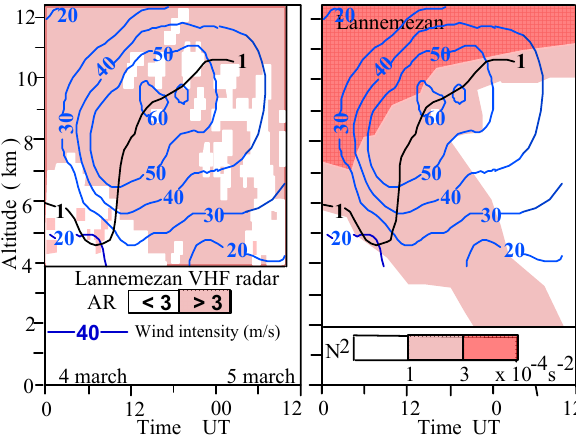
Fig. 6. Time-height cross section of (a) the Toulon VHF radar as- pect ratio ( AR ) and (b) the ECMWF model static stability on 4 and 5 March 1995. Also drawn in (a) and (b) is the wind field (in m/s), observed by the Toulon radar, and the potential vorticity iso-line PV = 1 PV units (black line), deducted from the ECMWF model analysis which has been found (in Fig. 5) to be a good tracer of the fold.